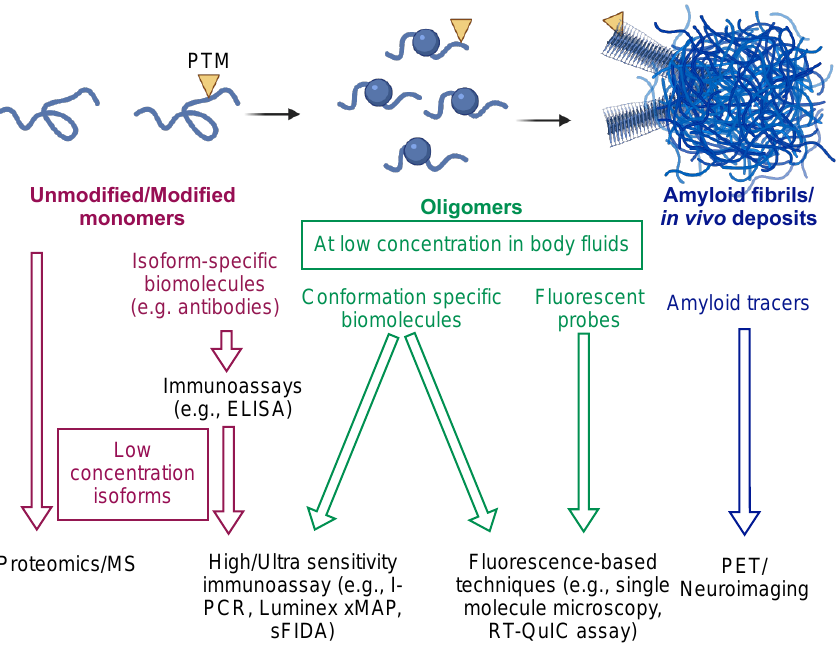
Figure 3. Detection of amyloidogenic proteins at different stages of protein aggregation. Main representative strategies and techniques are shown.